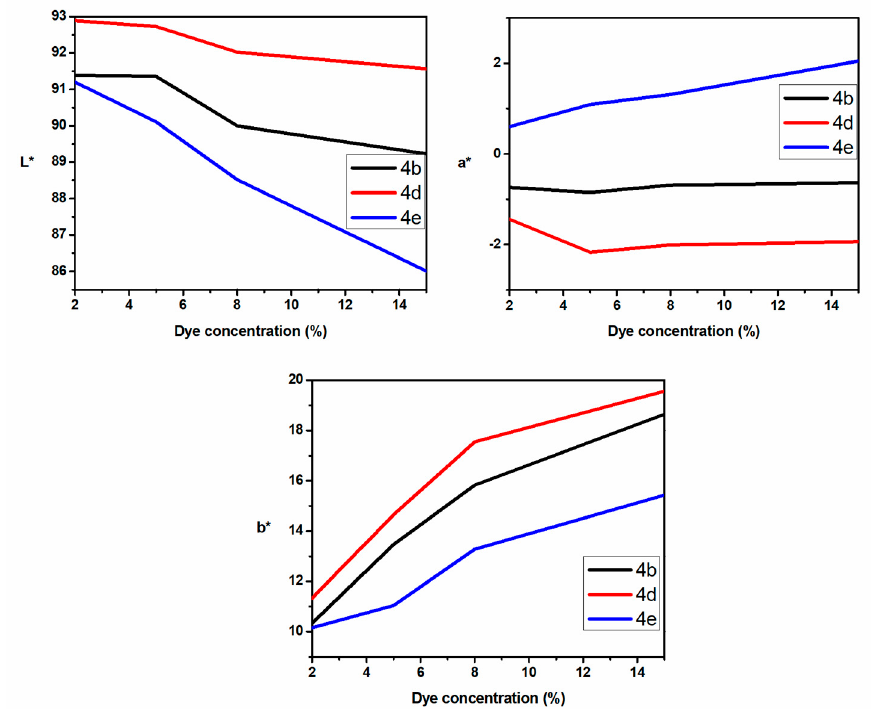
Figure 5. The dependence of CIEL*a*b* parameters on the dye concentration for dyes 4b , 4d , and 4e .